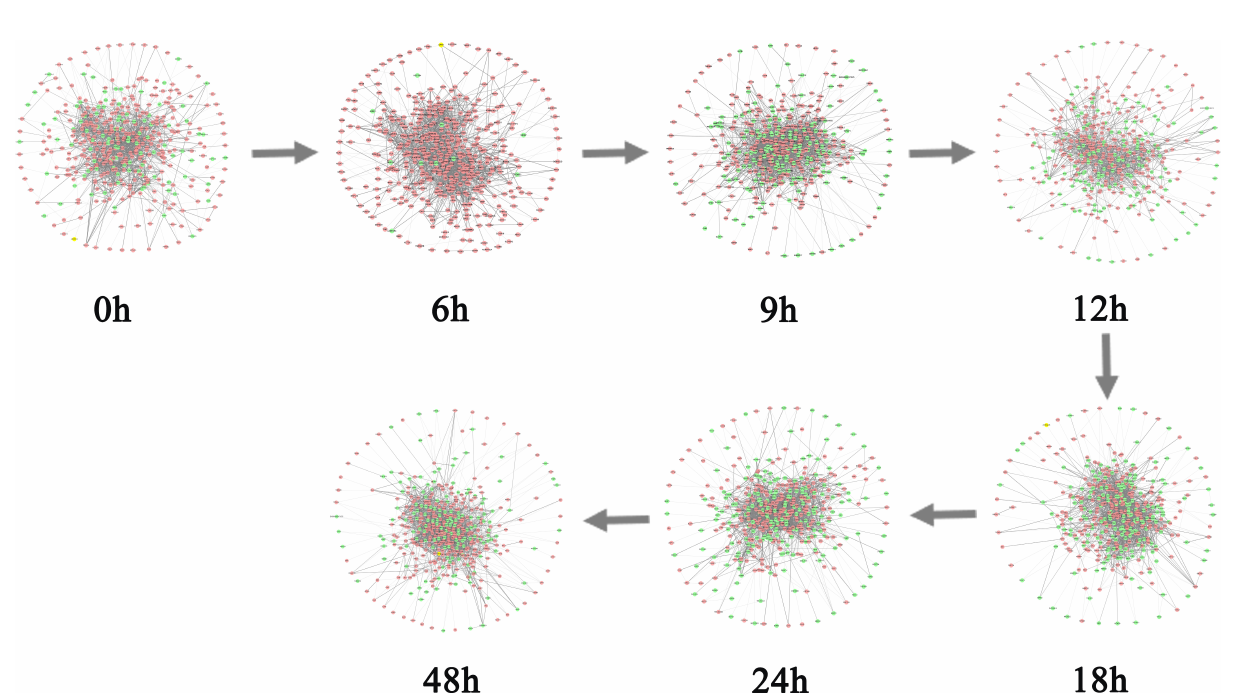
FIGURE 4 | The dynamic evolution of sJSD signal biomarkers. The PPI network shows the dynamic structural changes of sJSD signal biomarkers, in which red circles represent sJSD signal biomarker genes and green circles represent non-sJSD signal biomarker genes. It can be seen that at the 6 th hour, the sJSD signal biomarkers become more active, and the network structure undergoes signi fi cant changes.